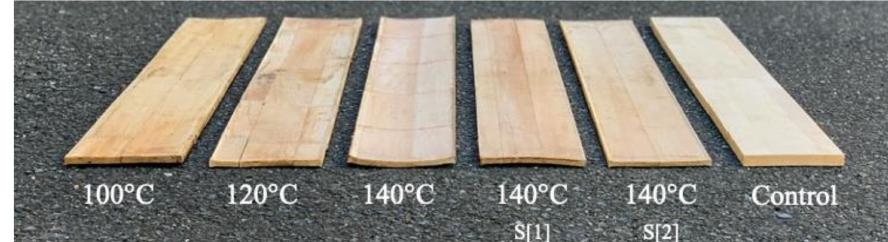
Figure 7. Comparison of Albizia falcataria boards, both treated and control.